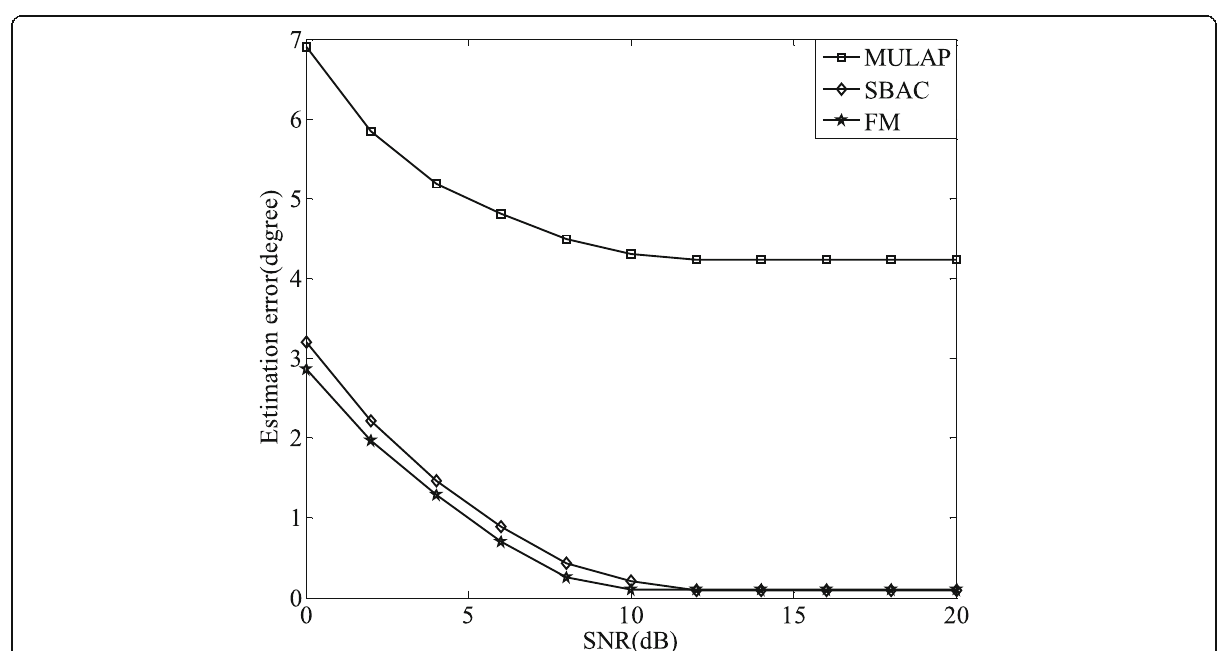
Fig. 7 Estimation errors versus SNR when FS and NS are close to each other